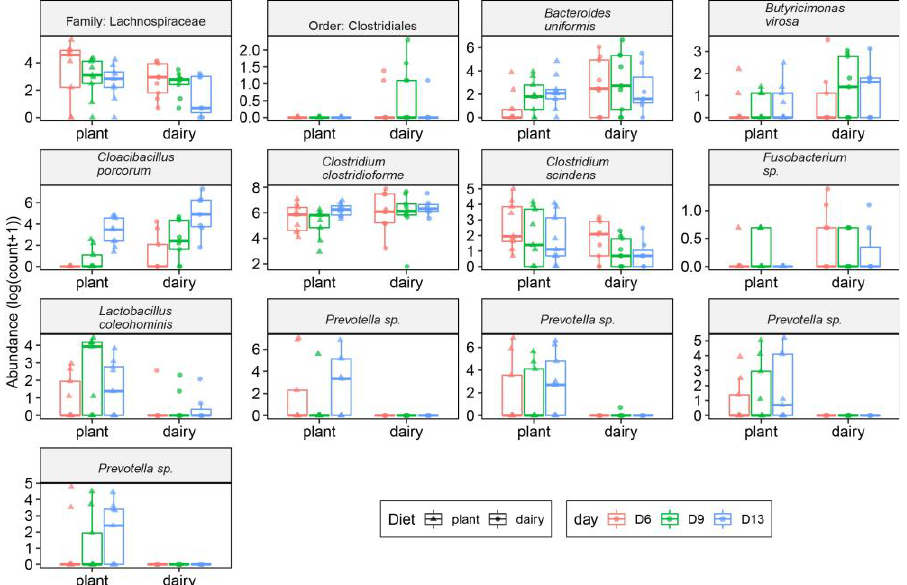
Figure 5. Differentially abundant bacteria in the feces collected at days 6, 9, and 13 of age in piglets ( n = 9 per group) fed either a plant- or a dairy-based formula diet. Data generated by 16S rRNA amplicon sequencing targeting the V3 – V4 variable region. Differential abundance of sequencing counts (OTUs) was assessed using linear mixed models. Significant differences were considered at p < 0.05 after correcting for false discovery correction using the BH method. All the data shown were significant between diet groups. Operational taxonomy units (OTUs) were considered if at least 40% of samples contained a minimum of five counts. Only the significantly abundant taxa are shown.